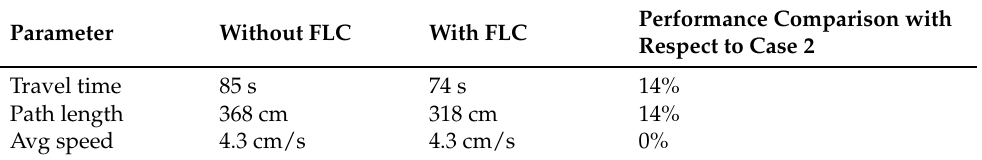
Table 1. Summarised test results of Experiment